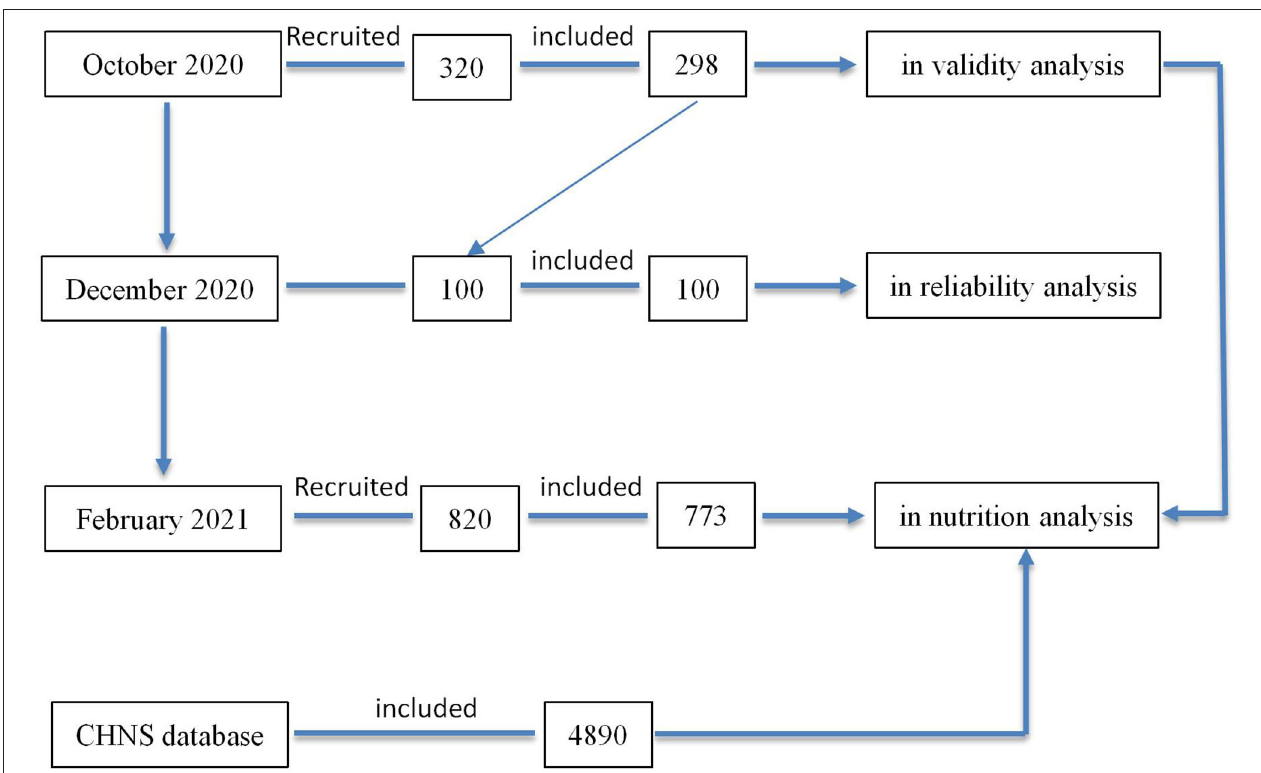
FIGURE 1 | The number of participants in different surveys and survey process.